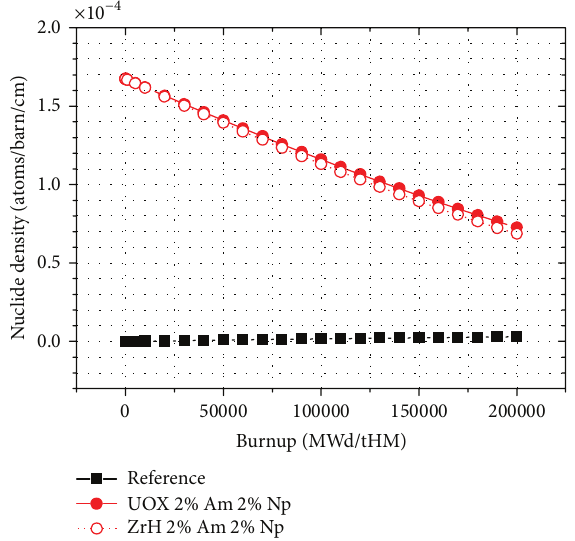
Figure 6: Change in the Neptunium-237 content over burnup for the case with and without